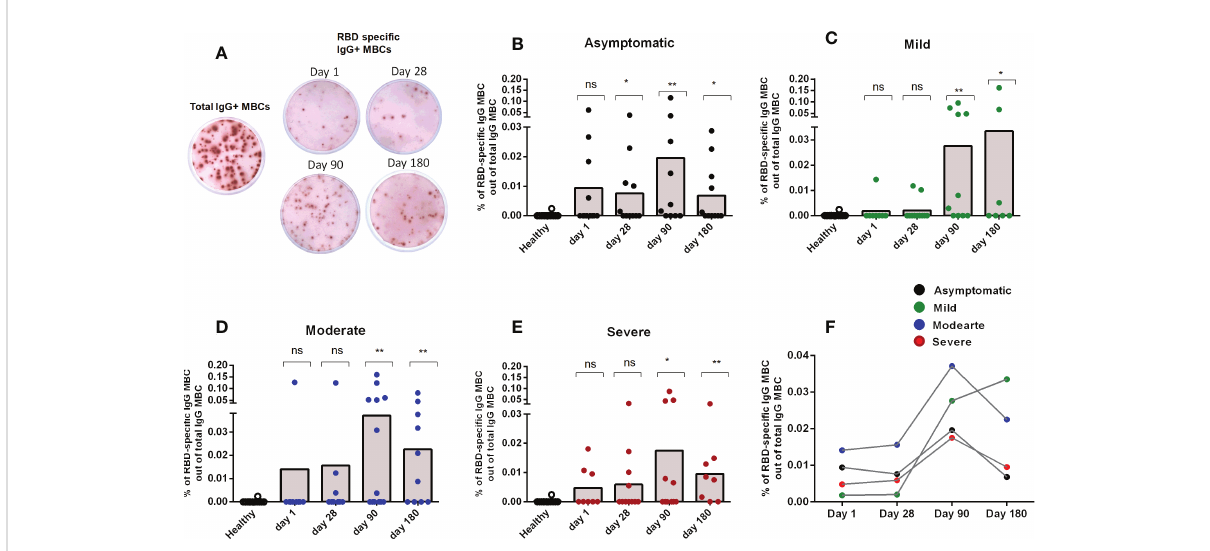
FIGURE 2 Memory B cell responses in COVID-19 patients with differing disease severity, compared to healthy controls. (A) Representative image of total and RBD-speci fi c IgG+ MBC spots. Frequency of RBD speci fi c IgG+ MBC within the total IgG+ MBCs from healthy adults (n = 10), as well as patients with (B) asymptomatic (n = 10-11), (C) mild (n = 8-11), (D) moderate (n = 9-13), and (E) severe (n = 8-11) COVID-19 on day 1, 28, 90 and 180. Each symbol represents one individual, and bars indicate mean values. Statistical analysis was performed between healthy controls and different time points in patients using the Mann-Whitney U test. (F) Line graphs showing mean values of the frequency of RBD speci fi c IgG+ MBC within the total IgG+ MBCs in patients with differing severity of infection. No signi fi cant difference in the frequency of MBCs were found between the groups with differing severity of infection. Total and antigen-speci fi c MBC spots were calculated as IgG spots/10 6 cells. Frequencies of MBCs against RBD are expressed as the percentages of speci fi c MBCs per total IgG MBCs. * P < 0.05, ** P < 0.01, *** P < 0.001, ns, not signi fi cant; P >